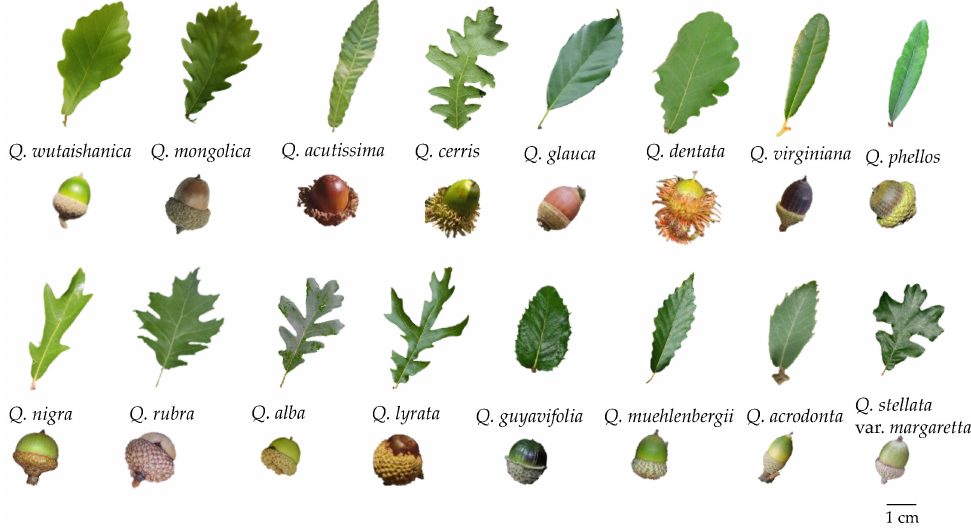
Figure 2. Morphology and diversity of leaves and acorns among a few oak species in